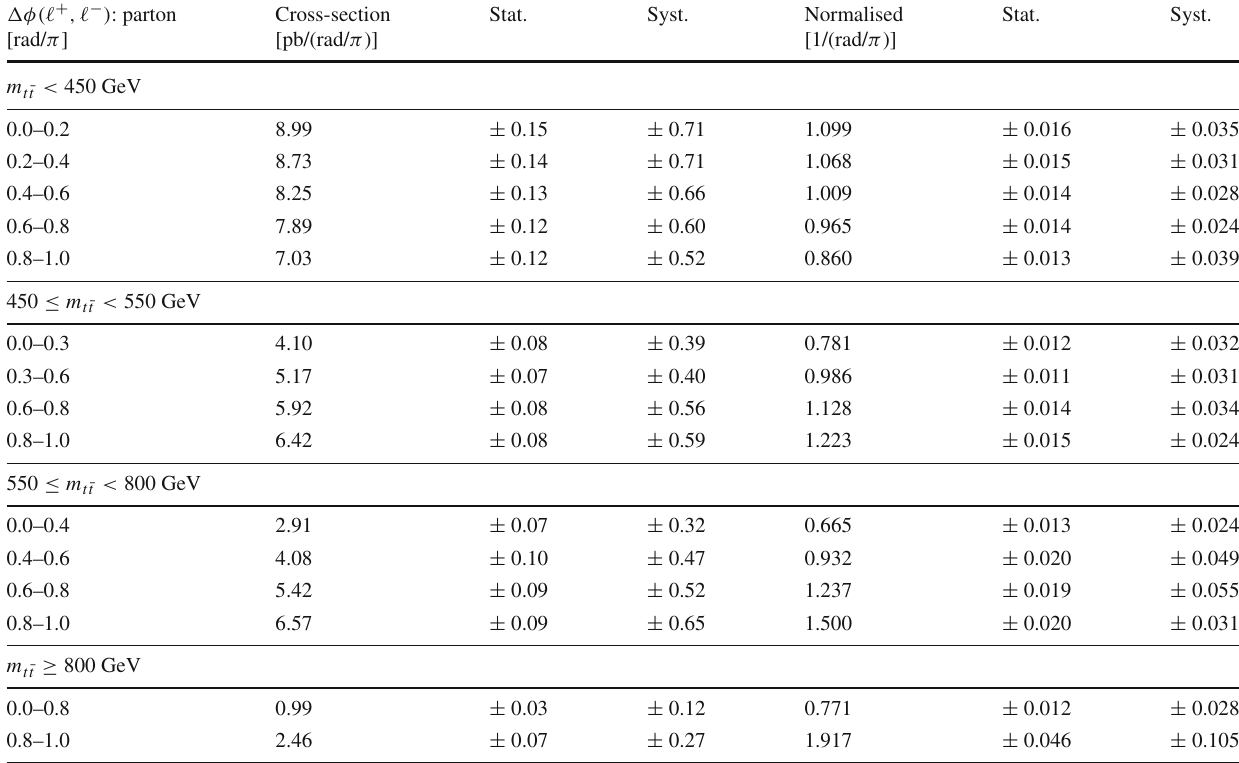
Table 4 Summary of the parton-level absolute and normalised differential cross-sections as a function of (cid:3)φ((cid:13) + ,(cid:13) − ) in four regions of m t ¯ t , with statistical and systematic uncertainties in each bin (cid:3)φ((cid:13) + ,(cid:13) − ) : parton Cross-section Stat. Syst. Normalised Stat. Syst. [rad/ π ] [pb/(rad/ π )] [1/(rad/ π